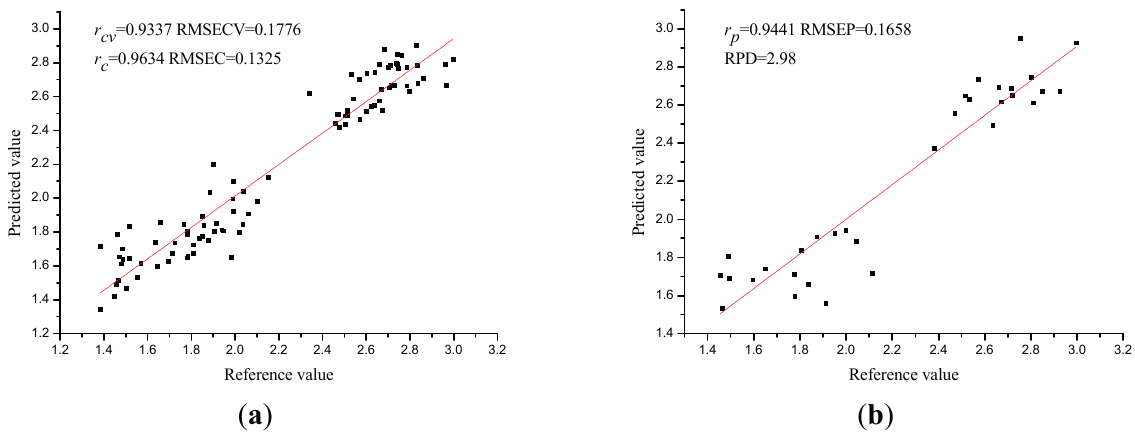
Figure 4. Prediction results of the prediction set ( a ) and the calibration set ( b ) of PLS model using full spectra. (The unit of RMSECV, RMSEC and RMSEP was mg/g in the entire paper).